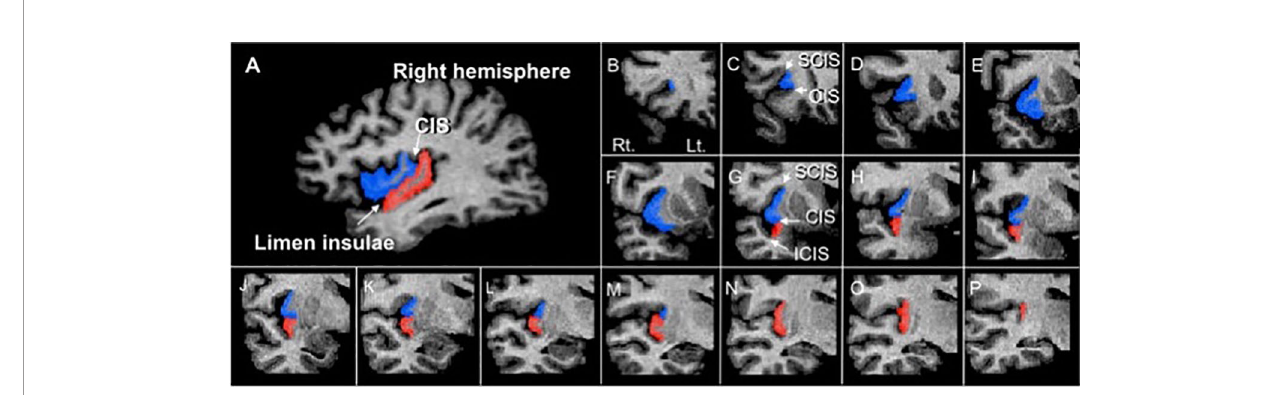
FIGURE 1 | A sagittal slice (A) and sample coronal slices (B – P) of short (blue) and long (red) insular cortices manually traced in this study. CIS, central insular sulcus; ICIS, inferior circular insular sulcus; OIS, orbitoinsular sulcus; SCIS, superior circular insular sulcus.